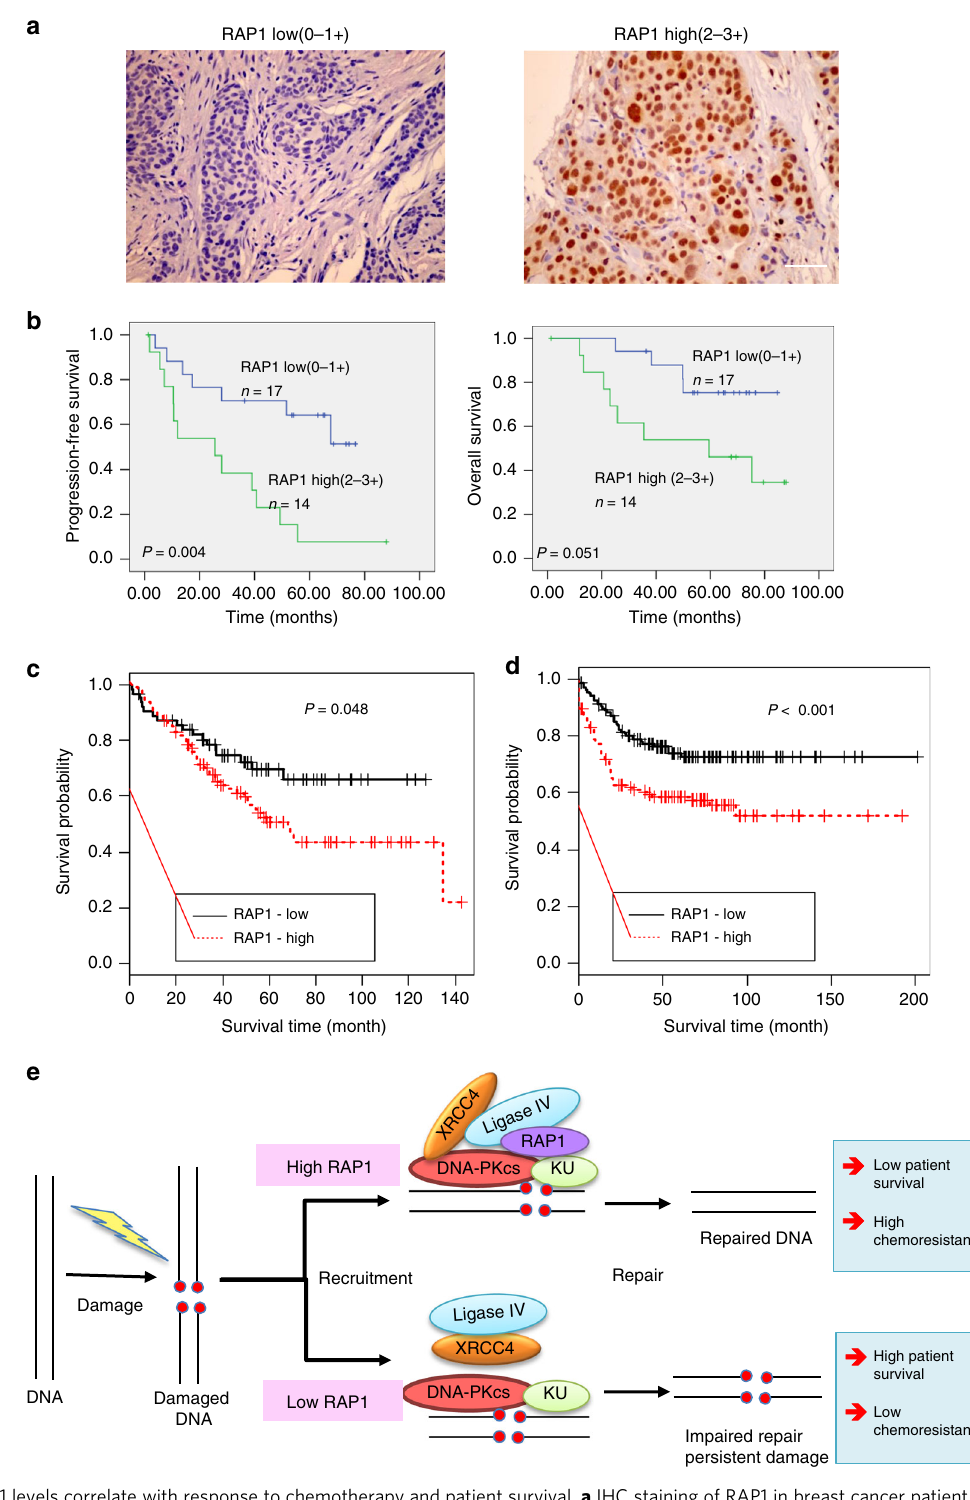
Fig. 7 RAP1 levels correlate with response to chemotherapy and patient survival. a IHC staining of RAP1 in breast cancer patient tissues. Staining intensity was classi fi ed into four groups: 0 (negative), 1 (weak), 2 (moderate), and 3 (strong). Staining scores 0 and 1 were grouped as negative immunoreactivity whereas 2 and 3 were grouped as positive immunoreactivity. Scale bar, 50 μ m. b Graphs showing correlation of progression free and overall survival with RAP1 levels ( n = 31). c , d For survival data analysis of colorectal cancers, raw gene expression data with GEO accession numbers of GSE17538 ( n = 232) and GSE39582 ( n = 1193) were downloaded from the GEO database (http://www.ncbi.nlm.nih.gov/geo/). Normalization of the raw data was performed across all samples based on the Cross Correlation method 63 . Strati fi cation of samples replied on the distribution of RAP1 (TERF2IP) expression intensities cross all samples. Ten percent below or over the RAP1 median expression value was used as the cutoff for selection of RAP1 lower or higher samples, respectively. The analysis of the survival data was based on the Kaplan – Meier method. e Model showing that RAP1 binds DDR complex proteins and regulates their formation and recruitment on